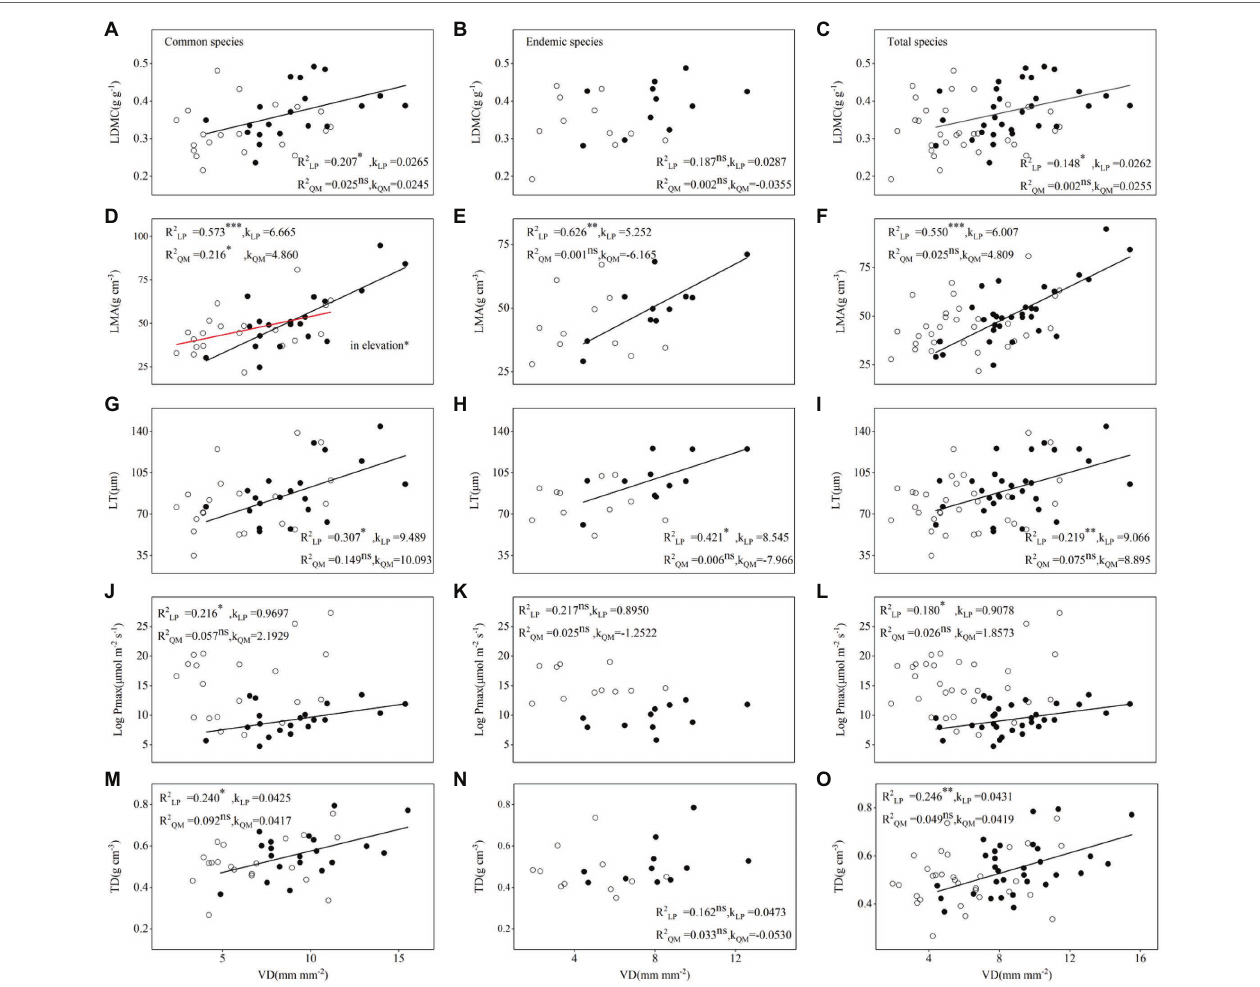
FIGURE 5 | Relationships between VD and (A-C) LDMC, (D-F) LMA, (G-I) LT, (J-L) P max , (M-O) TD of congeneric species (20 pairs of congeneric common species, 11 pairs of congeneric endemic species and 31 pairs of congeneric species) in Loess plateau (low soil water availability; closed circles) and Qinling Mountain (high soil water availability; open circles). Linear regressions were fitted to the data (black regression lines, LP; red regression lines, QM). Values of R 2 are followed by significance level (*, p < 0.05; **, p < 0.01; ***, and p < 0.001). Values of K represent slopes of lines.